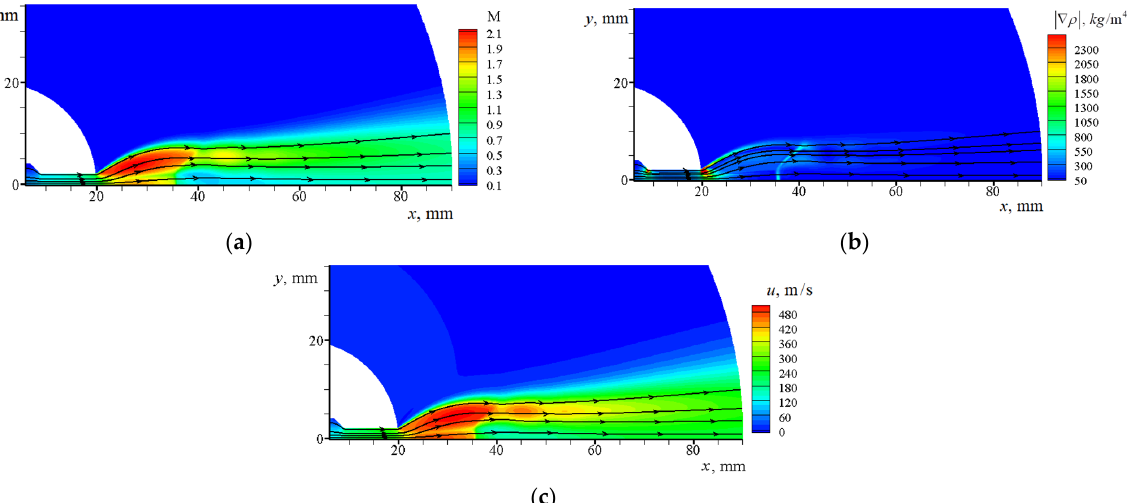
Figure 19. Calculated data for a two ‐ phase jet without particles exhausting from a channel into a slotted space with h = 0.8 mm: ( a )—Mach ‐ number isolines M( , ) x y and gas ‐ flow streamlines; ( b )— isolines of density gradient  .